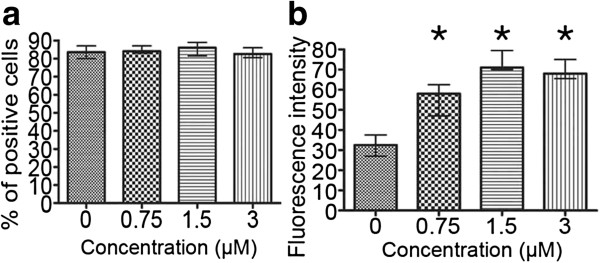
a-b Quantity of vimentin protein in the A549 population after treatment with etoposide - statistical data from flow cytometric analyses. a Percentage of vimentin-positive cells, b fluorescence intensity reflecting vimentin content. Statistically significant differences were not observed as compared to the control cells (Mann–Whitney U statistics, P<0.05). Columns - median percentage of vimentin-positive cells, bars - interquartile range. Results are representative of five independent experiments.